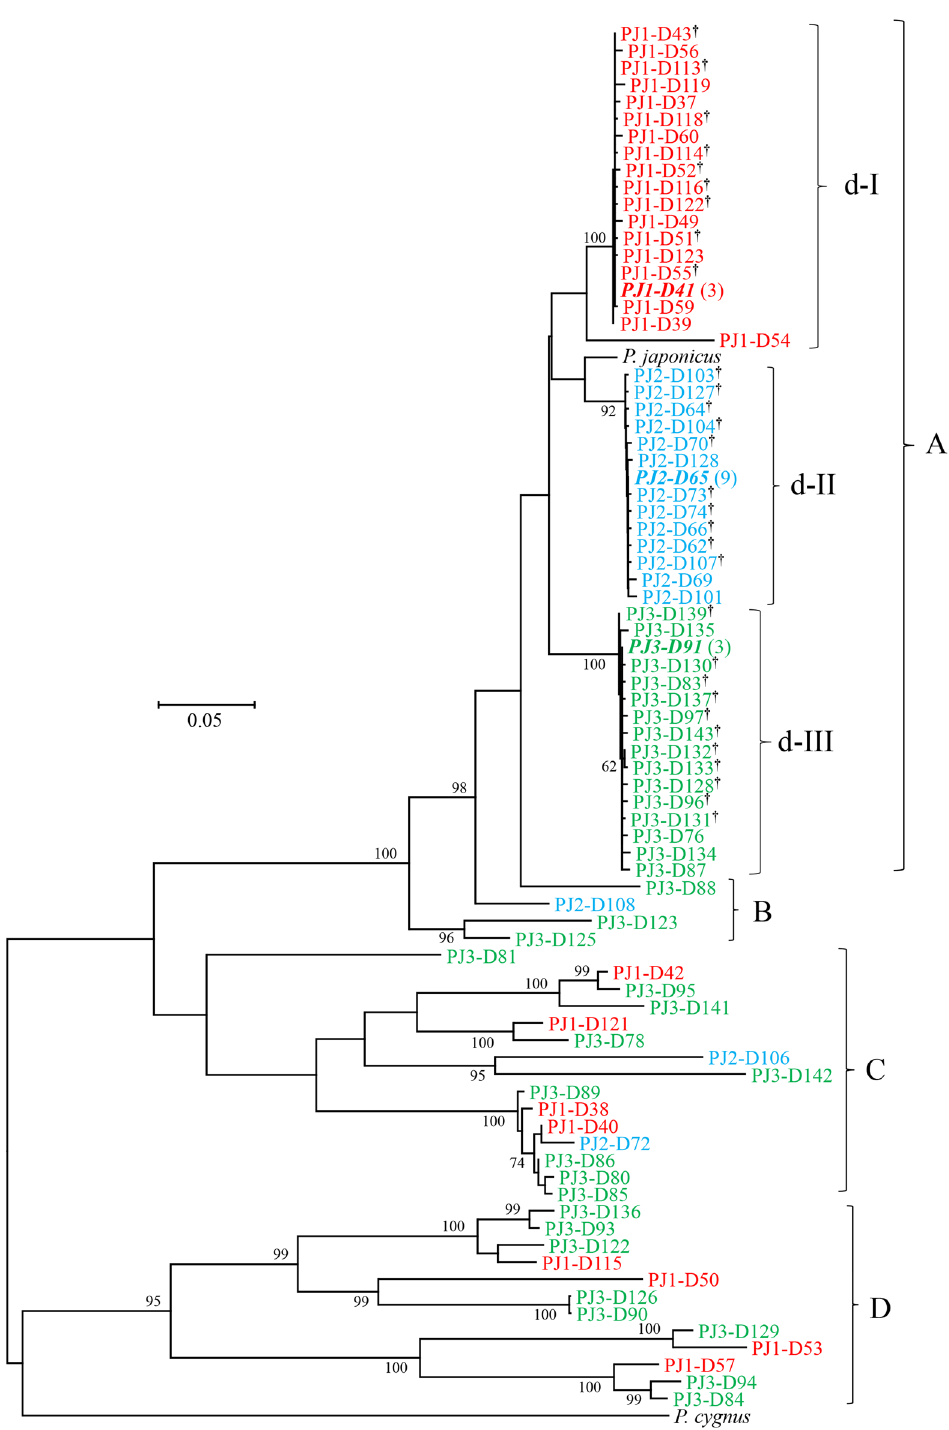
Figure 3. Neighbor-joining phylogenetic (NJ) tree showing relationships among 80 different haplotypes of control region (Dloop) or Dloop-like sequences obtained from the Japanese spiny lobster ( Panulirus japonicus ), and control region sequences of P. japonicus and P. cygnus derived from the GenBank database. Haplotypes detected from the same lobster individual share the same color. Genuine mtDNA haplotype is shown in bold italic and number of clones examined is shown in parenthesis. Haplotypes carrying dagger differ from corresponding genuine mtDNA haplotype by less than two nucleotides (including indel). The bootstrap values greater than 60% (out of 1000 replicates) are shown at the